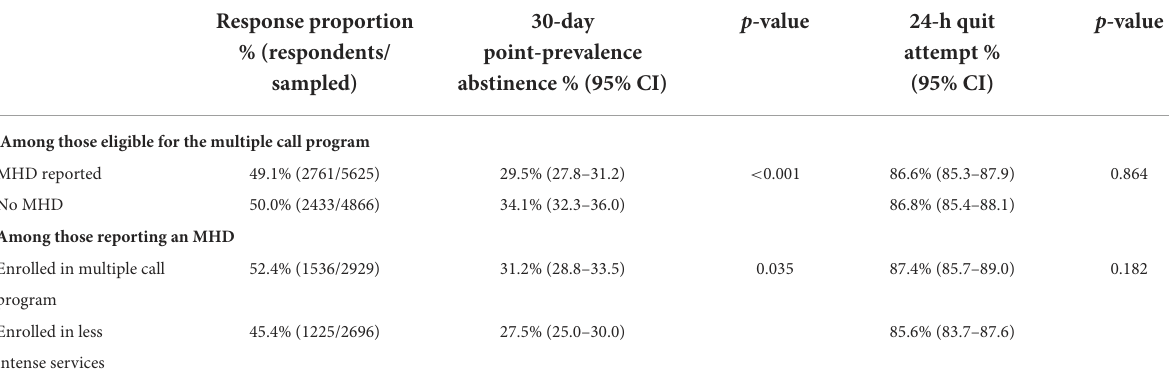
TABLE 4 Quit outcomes by mental health disorder (MHD) status and program